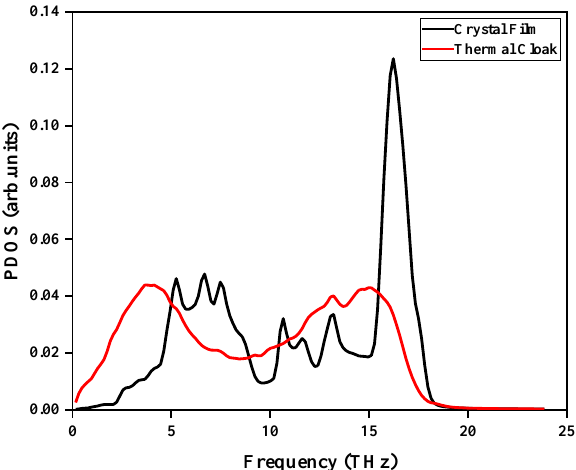
Figure 7. PDOS in the calculated region of the different structures.